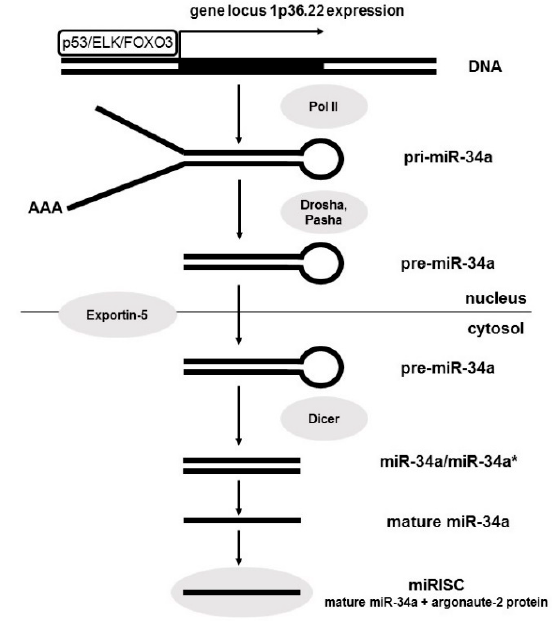
Figure 1. MiR-34a biogenesis.